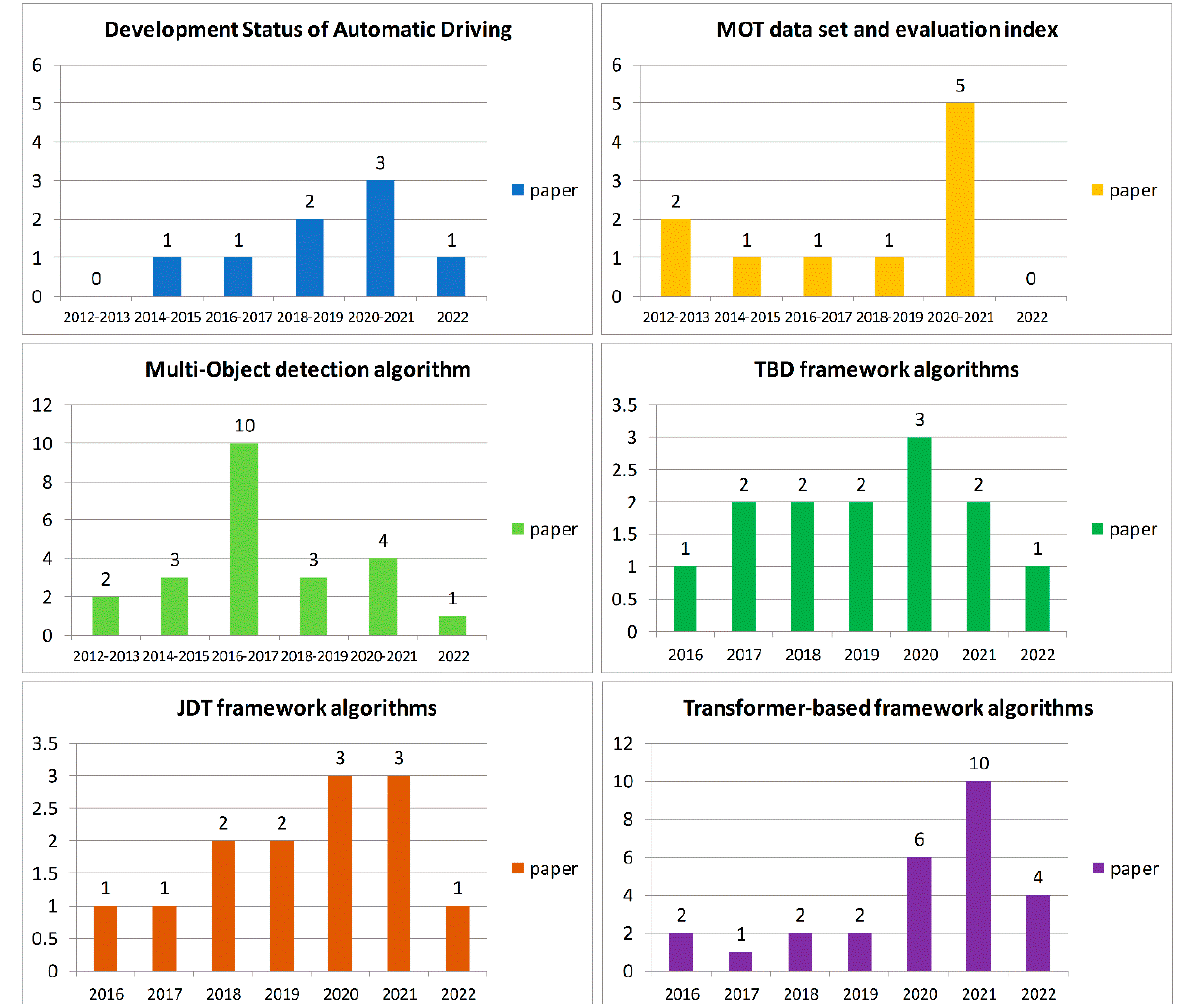
Figure 2. We studied the relevant literature over the past decade, according to the inclusion and exclusion criteria, we finally selected 98 papers as our research object. We divide the paper into six parts and count them in chronological